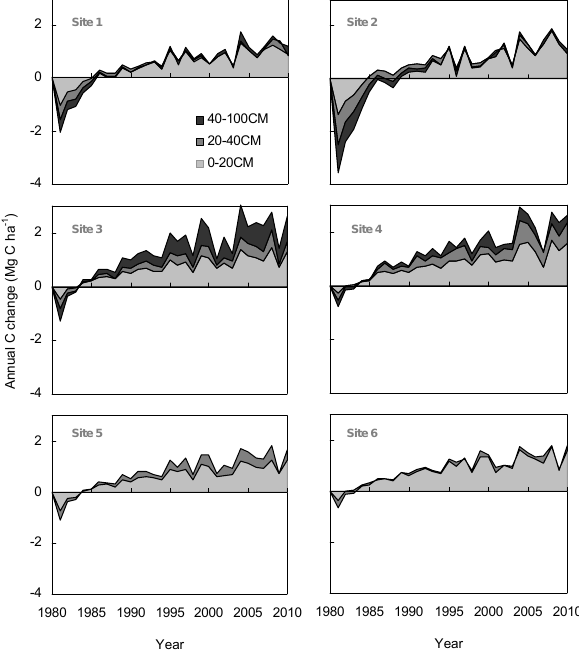
Fig. 9. Simulated annual SOC change over time since afforestation at the six study